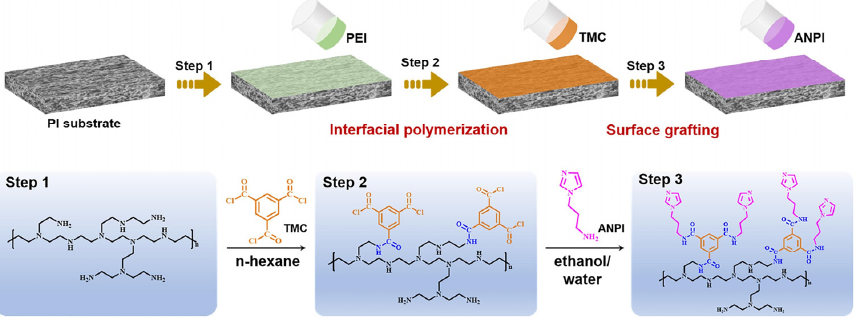
Figure 3. Schematic diagram of the fabrication process for ANPI-grafted composite membranes